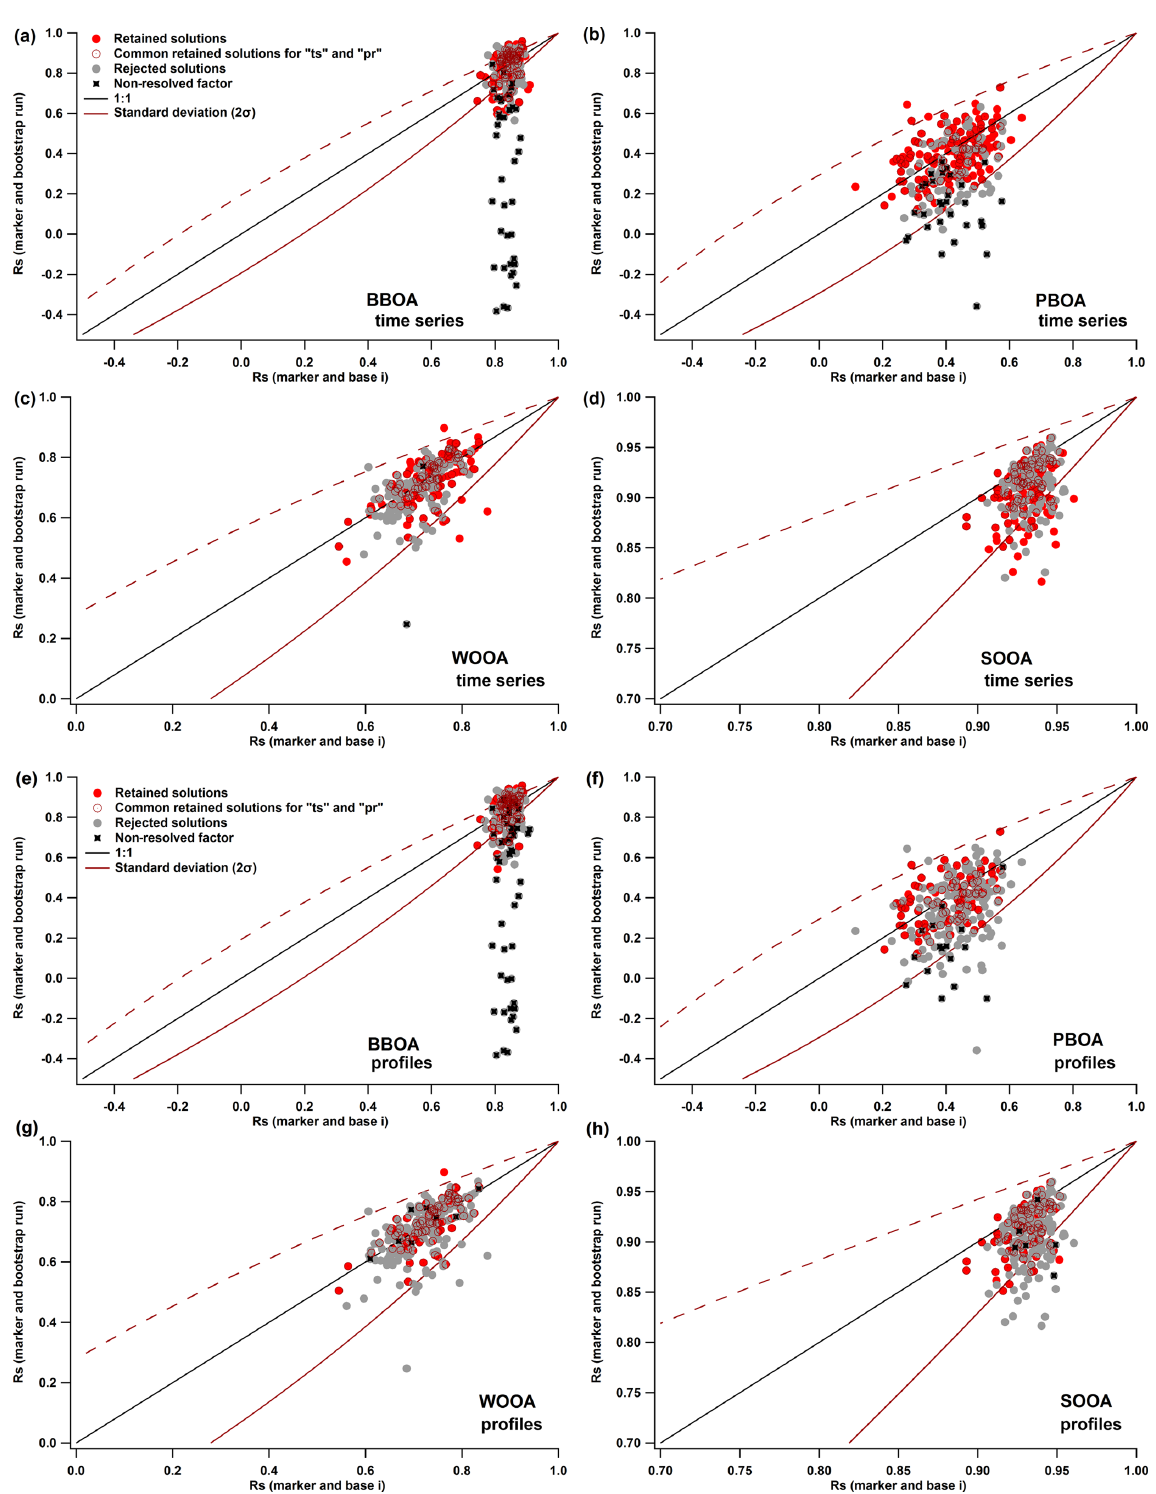
Figure 4. Scatterplots of R sboots between markers and bootstrap runs and R sbase between markers and base cases per factor: BBOA with levoglucosan (a) , PBOA with cellulose (b) , WOOA with phthalic acid (c) and SOOA with MBTCA (d) for the ts sorting method. The black points that lie below the 1 σ line (in solid dark red) indicate true negative solutions, whereas the black points within 2 σ indicate false negative solutions. The red points below 1 σ represent the false positive solutions, while the red points above are the true positive solutions. The respective scatterplots for the pr method are shown in (e) , (f) , (g) and (h) . Note the different R s scales per